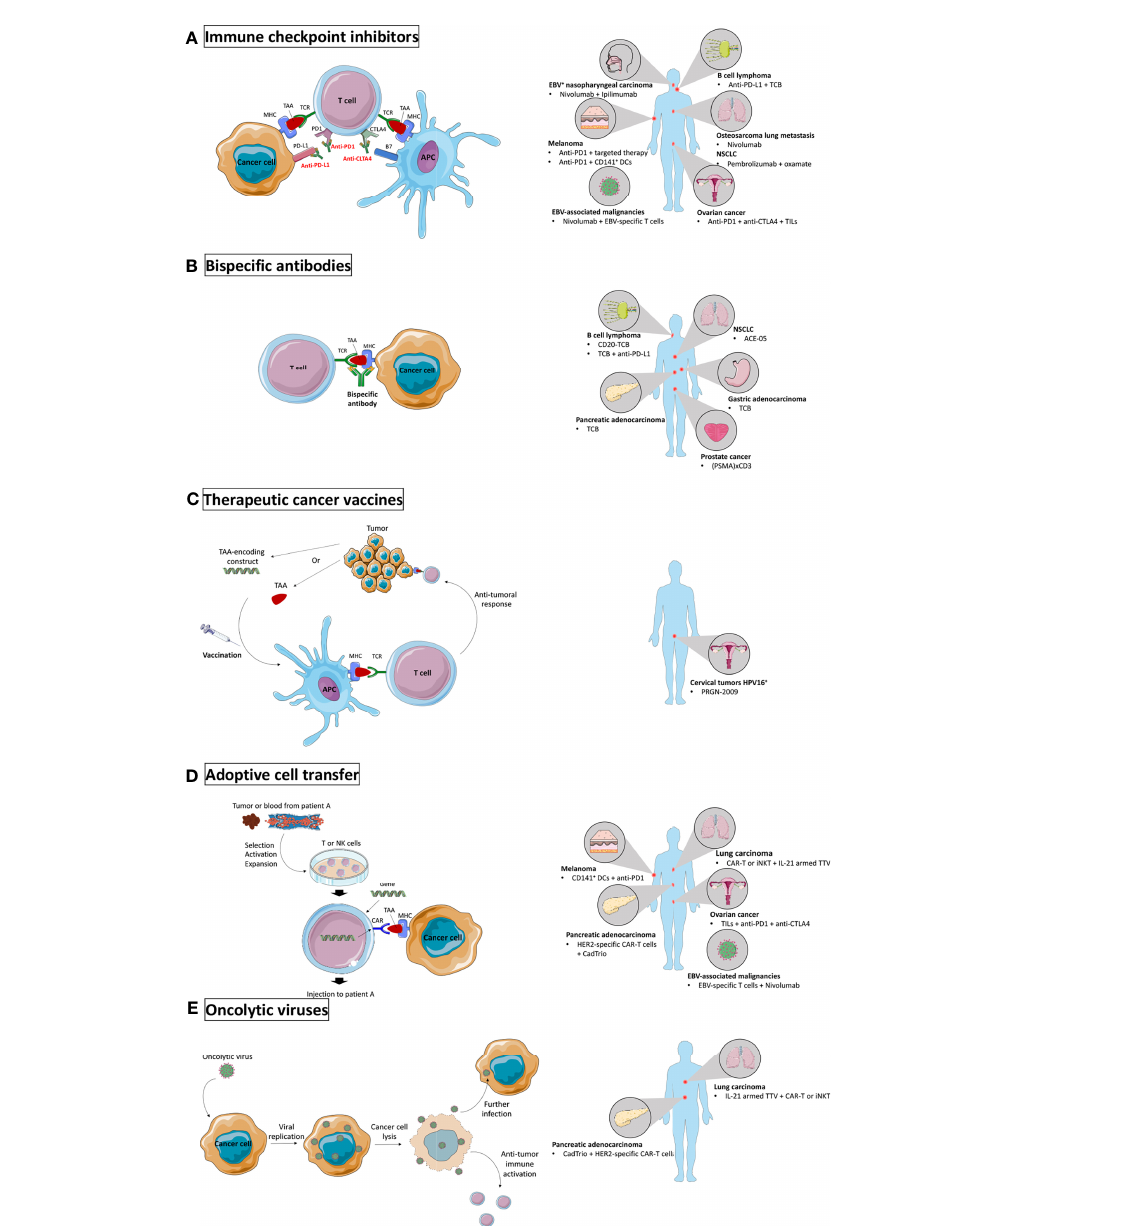
FIGURE 2 | Novel immunotherapy settings tested in humanized mice. (A) Immune checkpoint inhibitors (ICI) prevent engagement of inhibitory receptors and allow activation of anti-tumoral immune activity. ICI were tested in humanized mice to target EBV + nasopharyngeal carcinoma and other EBV-associated malignancies, melanoma, B cell lymphoma, osteosarcoma lung metastases, non-small cell lung carcinoma (NSCLC), and ovarian cancer. (B) Bispeci fi c antibodies form a bridge between two target cells and were tested in humanized mice to target B cell lymphoma, pancreatic adenocarcinoma, NSCLC, gastric adenocarcinoma, and prostate cancer. (C) Therapeutic cancer vaccines boost the anti-tumor activity by injecting TAAs or TAA-encoding constructs to the patient. They were tested in humanized mice to target HPV16 + cervical tumors. (D) Adoptive transfer of ex vivo modi fi ed immune cells to improve their anti-tumor activity has been tested in humanized mice to target melanoma, pancreatic adenocarcinoma, lung carcinoma, ovarian cancer, and EBV-associated malignancies. (E) Oncolytic viruses speci fi cally infect cancer cells and induce immunogenic cell death. They were tested in humanized mice to target pancreatic adenocarcinoma and lung carcinoma. Major histocompatibility complex (MHC); tumor associated antigen (TAA); T cell receptor (TCR); antigen presenting cell (APC); programmed cell death 1 (PD1); programmed death-ligand 1 (PD-L1); cytotoxic T lymphocyte antigen 4 (CTLA4); Epstein-Barr virus (EBV); cluster of differentiation (CD); dendritic cells (DCs); T cell bispeci fi c (TCB); tumor in fi ltrating lymphocytes (TILs); prostate-speci fi c membrane antigen (PSMA); human papillomavirus (HPV); natural killer (NK); chimeric antigen receptor (CAR); human epidermal growth factor receptor 2 (HER2); invariant natural killer T (iNKT); interleukin (IL); Torque Teno virus